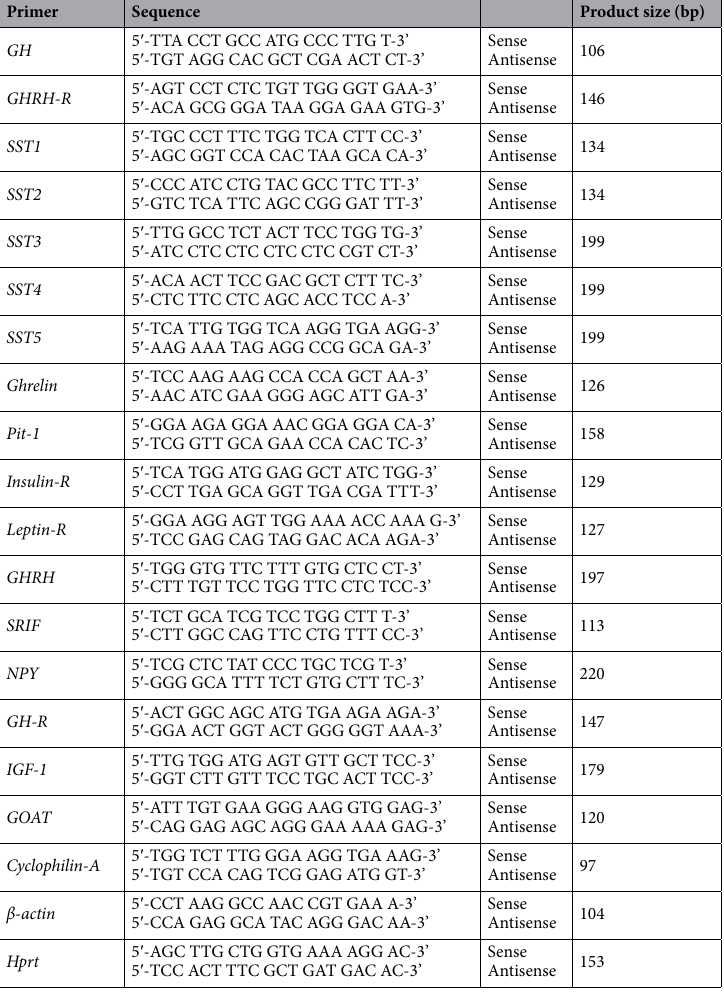
Table 1. Specific sequence of primers used in the study for quantitative real-time PCR and product sizes. GH growth hormone; GHRH-R GH-releasing hormone-receptor; SST1, SST2 SST3, SST4 and SST5 somatostatin receptor 1, 2, 3, 4 and 5; GHRH GH-releasing hormone; SRIF somatostatin; NPY neuropeptide Y; GH-R growth hormone receptor; IGF-1 insulin-like growth factor-1; GOAT ghrelin-O-acyltransferase; Hprt